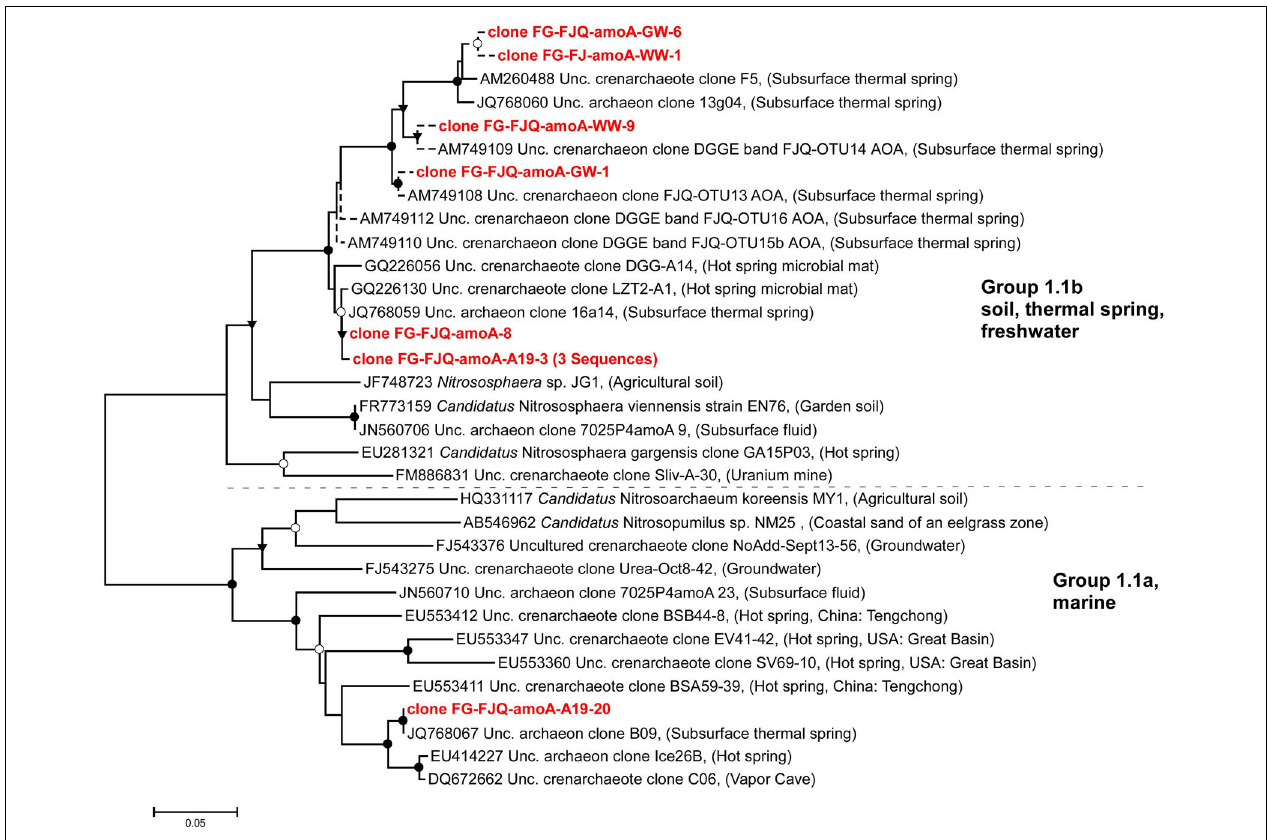
FIGURE 3 | Phylogenetic relationships among amoA sequences from FJQ microcosms and closest database sequences. Short sequences (256bp) are represented by dotted lines and did not change the overall topology of the tree. The tree was generated using the neighbor-joining method (NJ) and